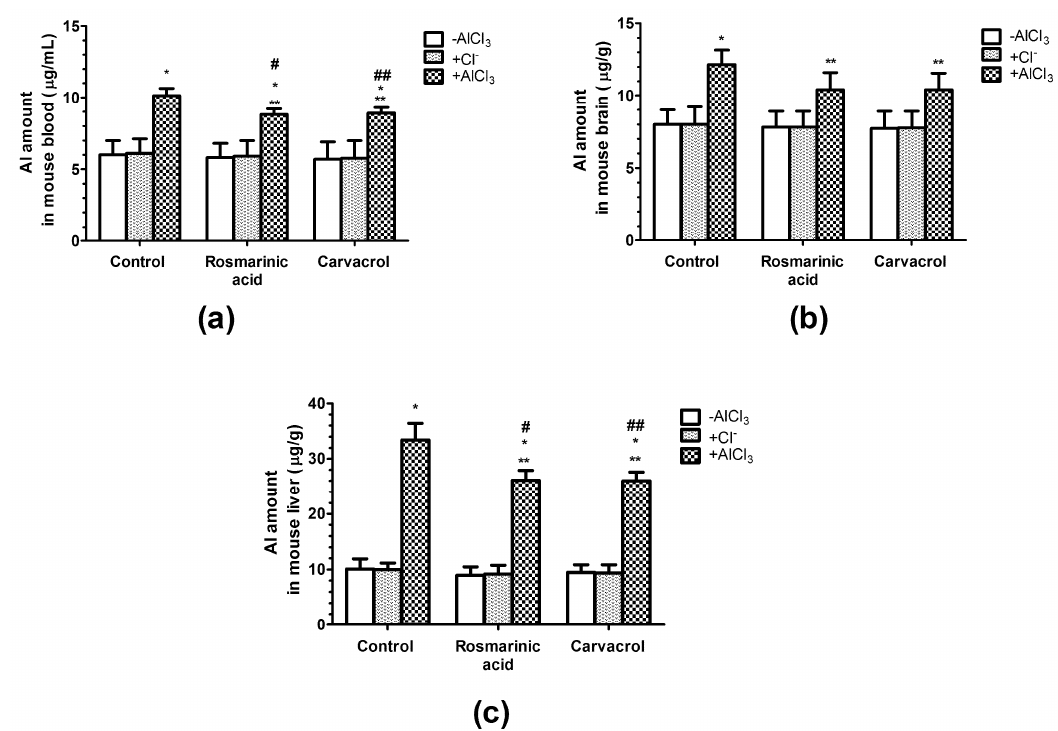
Figure 1. Influence of AlCl 3 , rosmarinc acid, and carvacrol on the amount of Al in mice blood ( a ) and brain ( b ) or liver ( c ) tissues. ( n = 9, * p < 0.001 vs. control, ** p < 0.001 vs. AlCl 3 , # p < 0.01 vs. rosmarinic acid in the absence of AlCl 3 , ## p < 0.01 vs. carvacrol in the absence of AlCl 3 ).